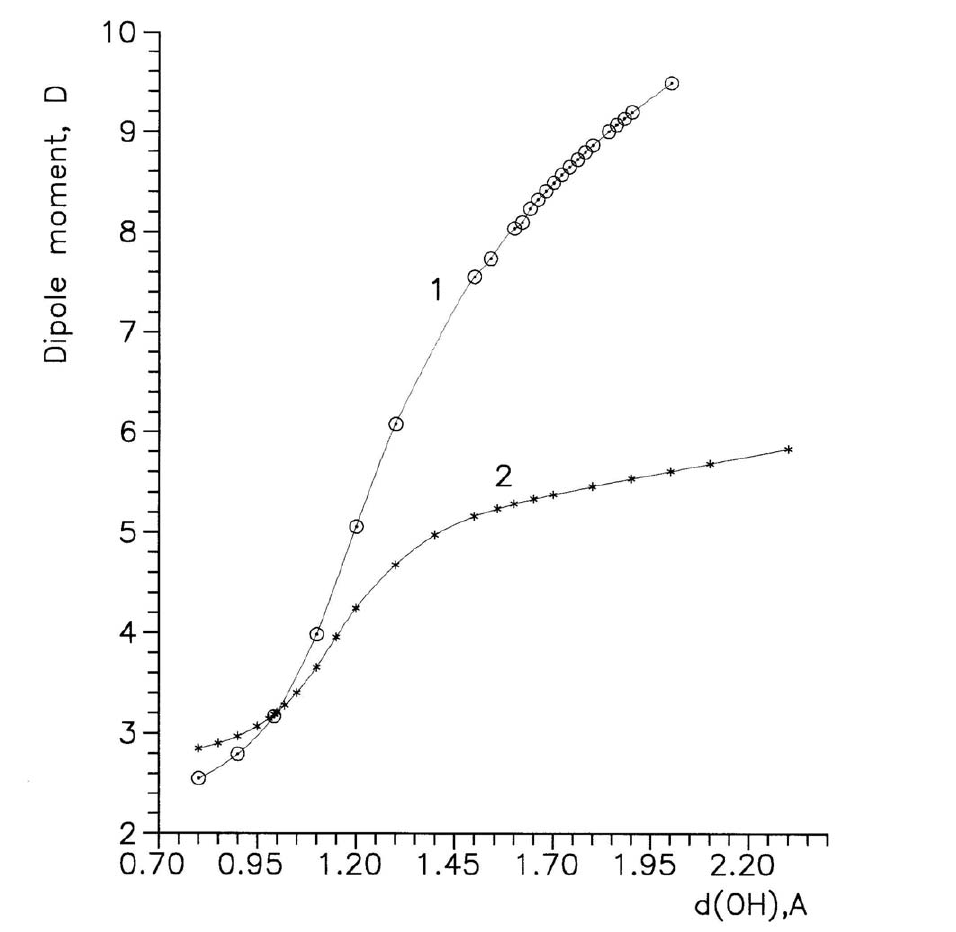
Figure 4. Dependence of calculated values of dipole moments on O … H distances in (1) Mannich base and (2)Schiff